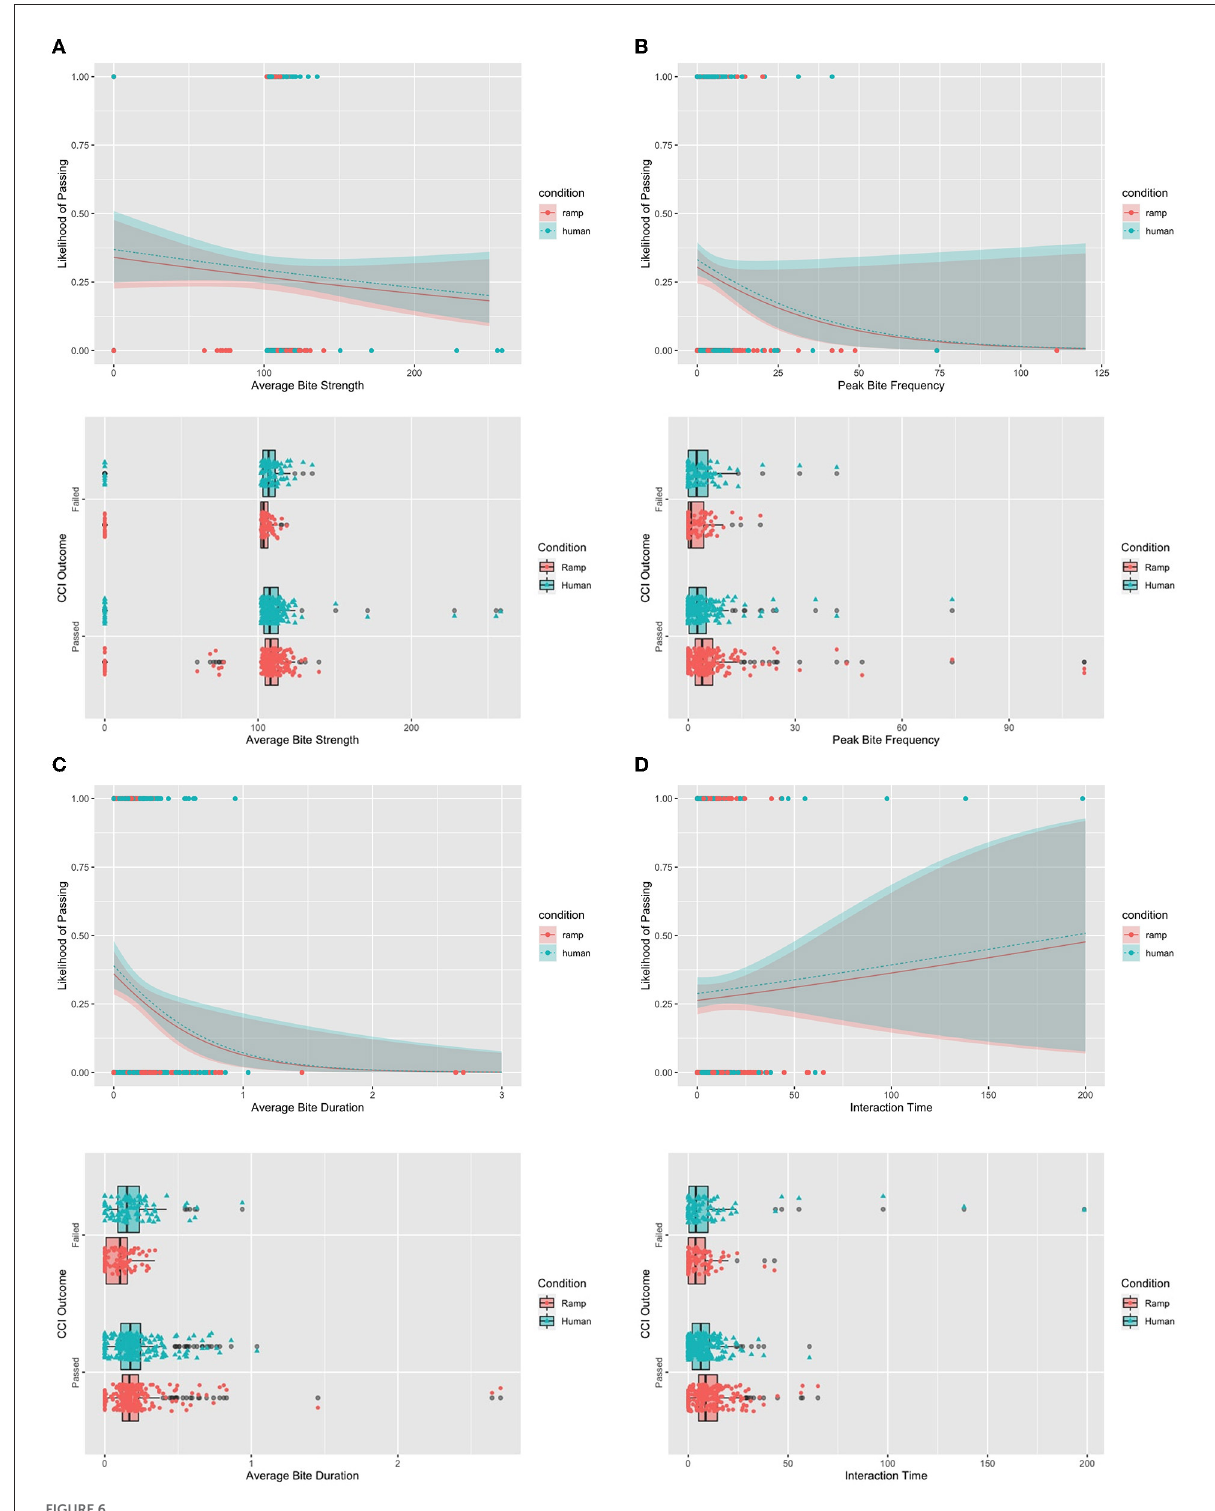
FIGURE6 Likelihood and distribution plots for each feature. (A) Top: The likelihood of passing the CCI criteria using average bite strength plotted by condition. Bottom: Distribution of average bite strength for each condition plotted against CCI outcome. (B) Top: The likelihood of passing the CCI criteria using peak bite frequency plotted by condition. Bottom: Distribution of peak bite frequency for each condition plotted against CCI outcome. (C) Top: The likelihood of passing the CCI criteria using average bite duration plotted by condition. Bottom: Distribution of average bite duration for each condition plotted against CCI outcome. (D) Top: The likelihood of passing the CCI criteria using interaction time plotted by condition. Bottom: Distribution of interaction time for each condition plotted against CCI